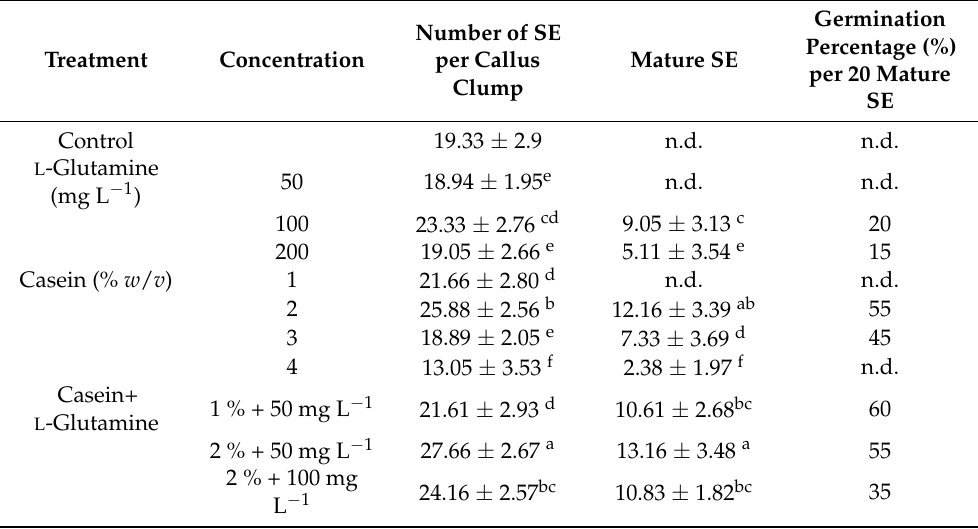
Table 2. Effect of L -glutamine and casein hydrolysate on somatic embryogenesis in 8-week calli of V. canescens grown on MS* medium.